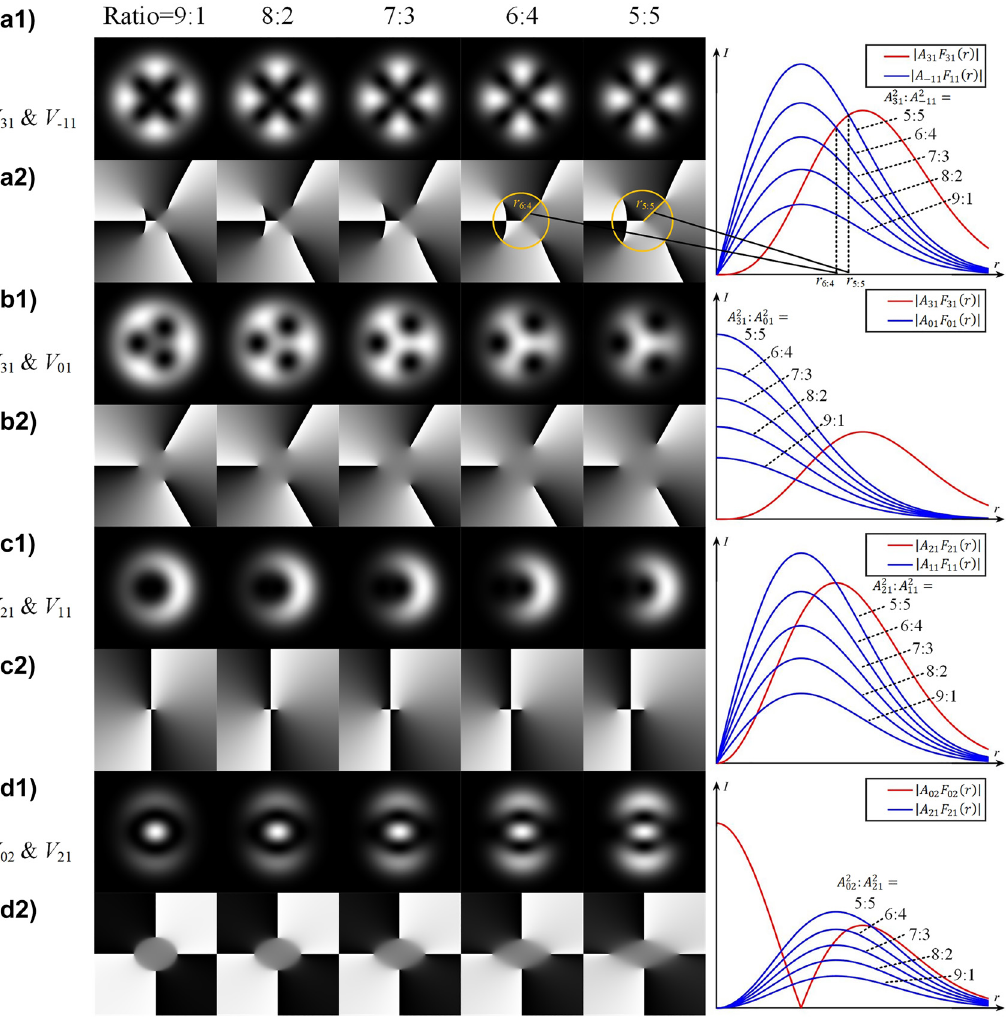
Figure 3: Singularities splitting phenomenon of hybrid-order vortex lights. The intensity and phase patterns of structured light combined by ((a1) and (a2)) V 31 and V − 11 , ((b1) and(b2)) V 31 and V 01 , ((c1) and (c2)) V 21 and V 11 , ((d1) and (d2)) V 02 and V 21 vortex lights with the intensity ratio from 9:1 decreasing to 5:5. The right curves are the corresponding radial functions along with the change of the total intensity